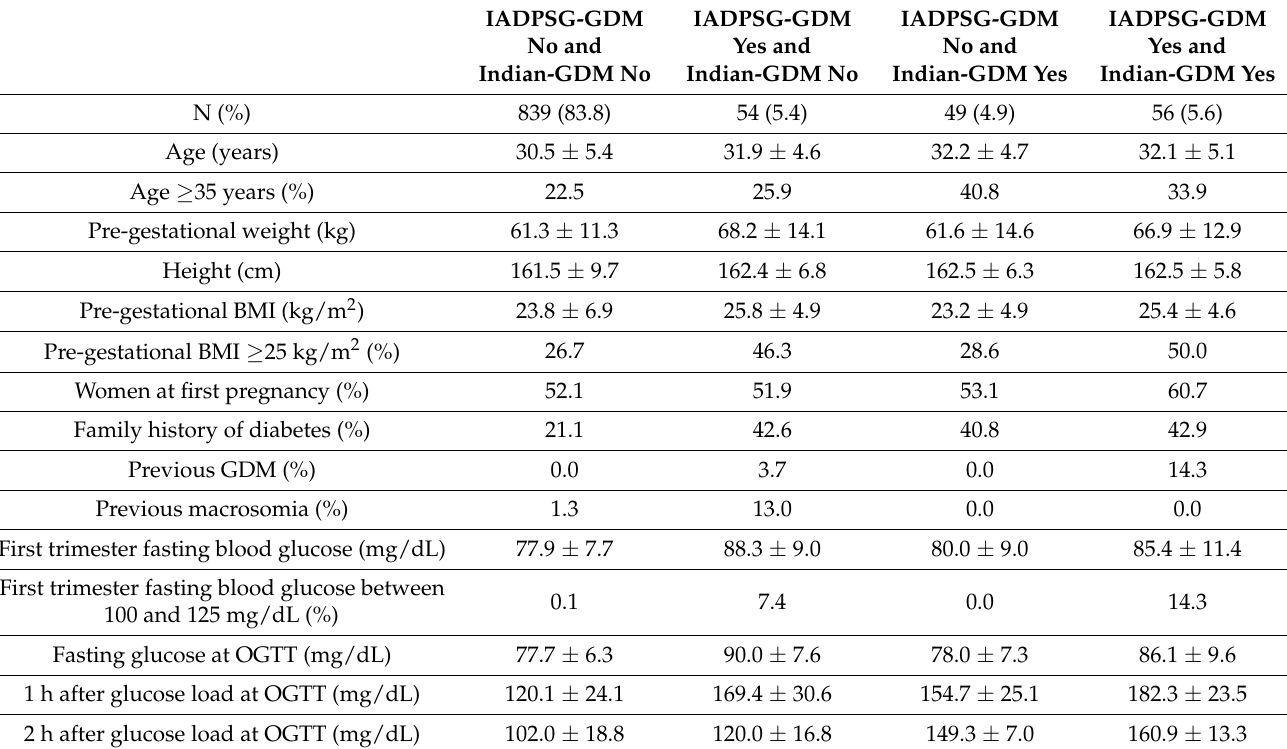
Table 2. Clinical characteristics of the study population according to the combination of IADPSG and Indian diagnostic criteria for gestational